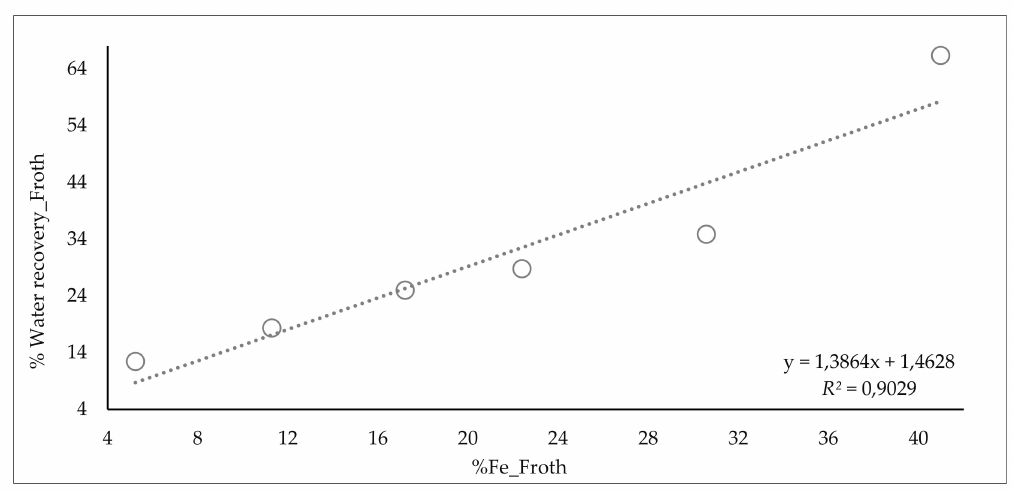
Figure 18. Trend between the Fe content in the froth and the water recovery in the